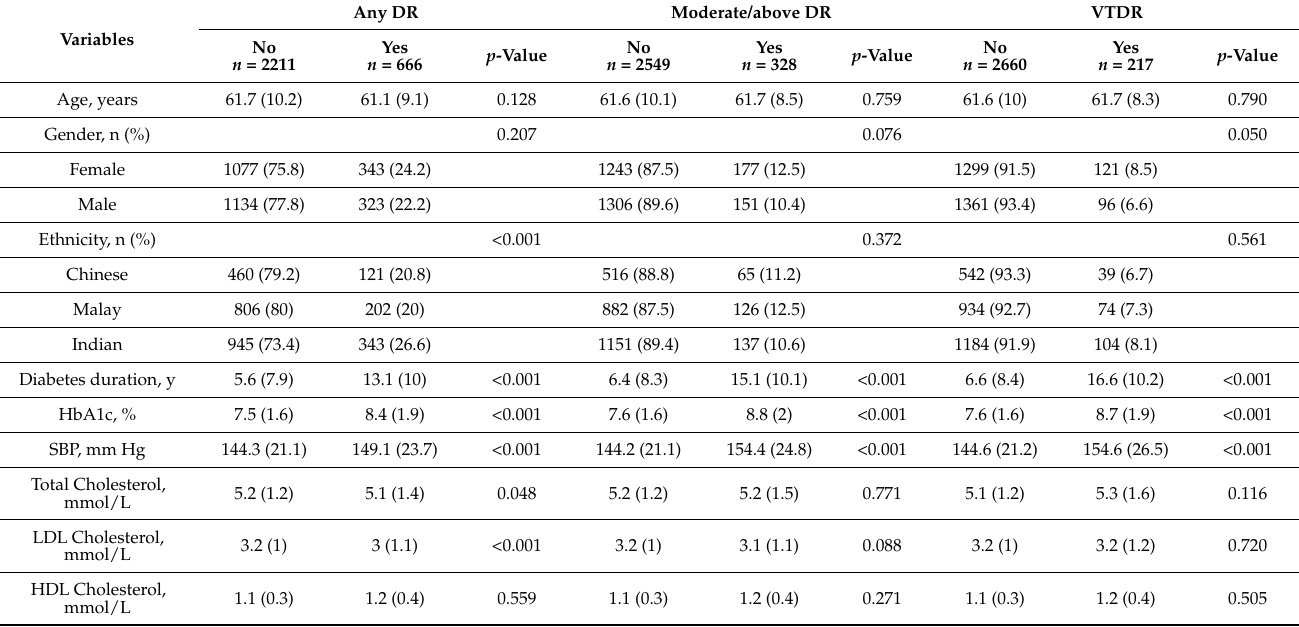
Table 1. Baseline characteristics of Chinese, Malay, and Indian cohorts stratified by DR